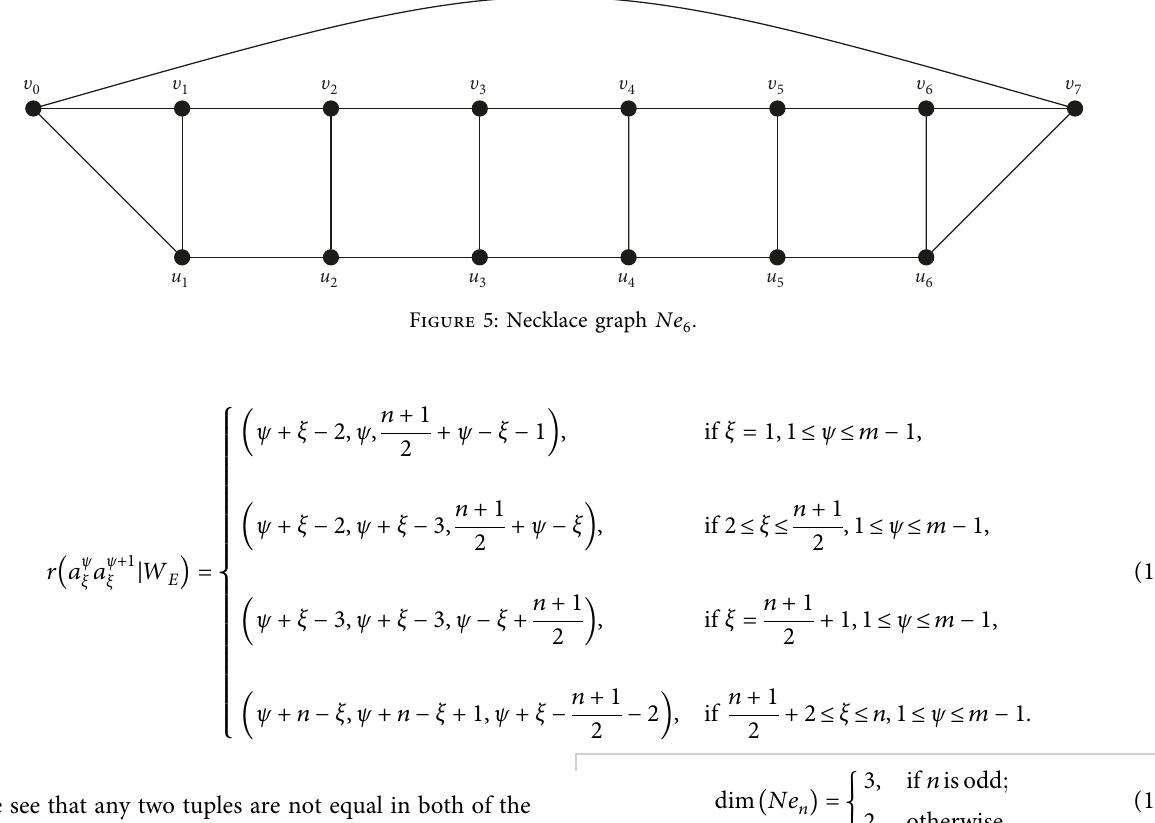
Figure 5: Necklace graph Ne